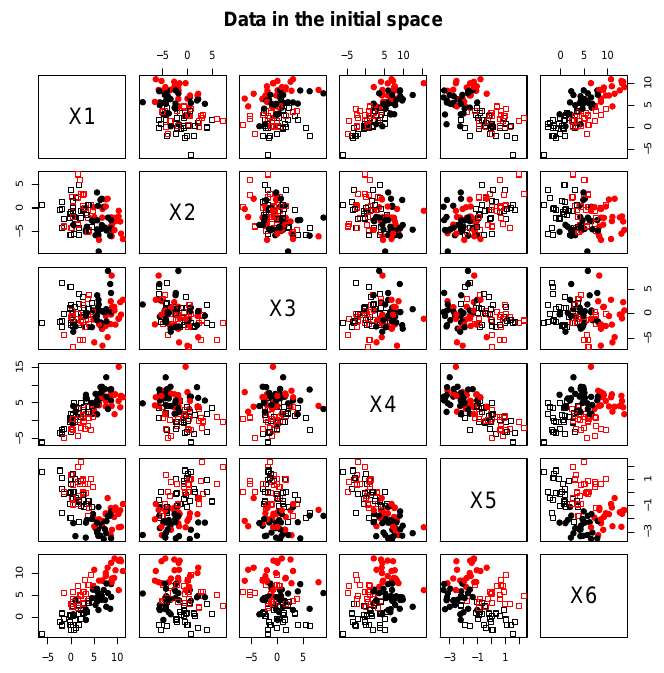
Figure 3. Scatter plots of the initial data on the illustrative example. The color depends on the first cluster variable, and the shape depends on the second cluster variable.